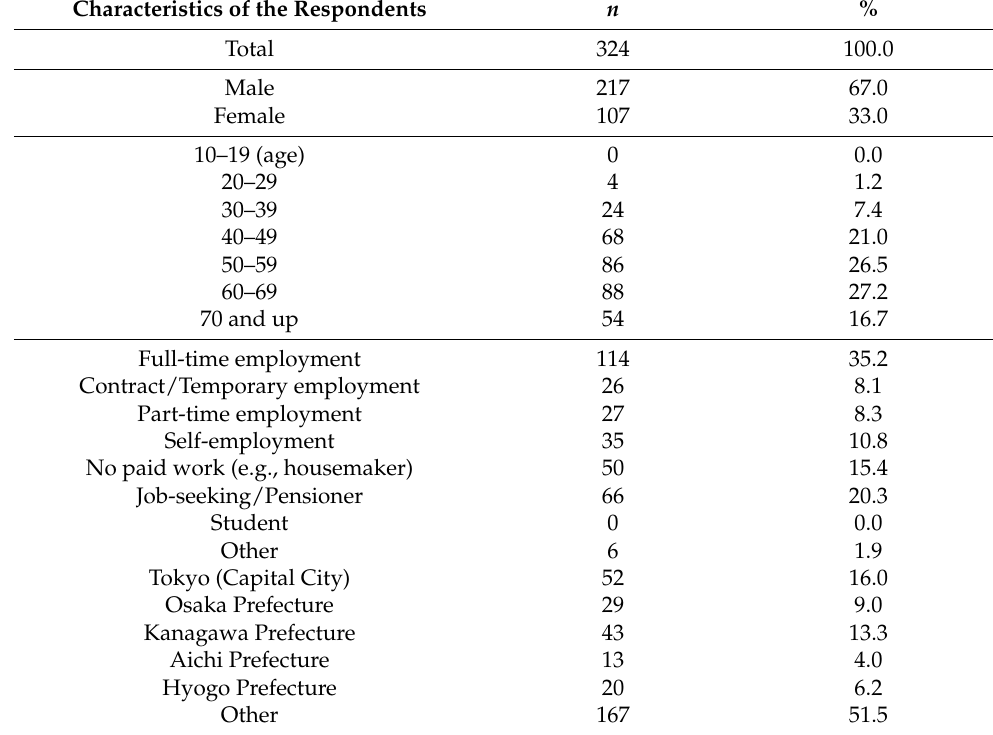
Table 2. Characteristics of the